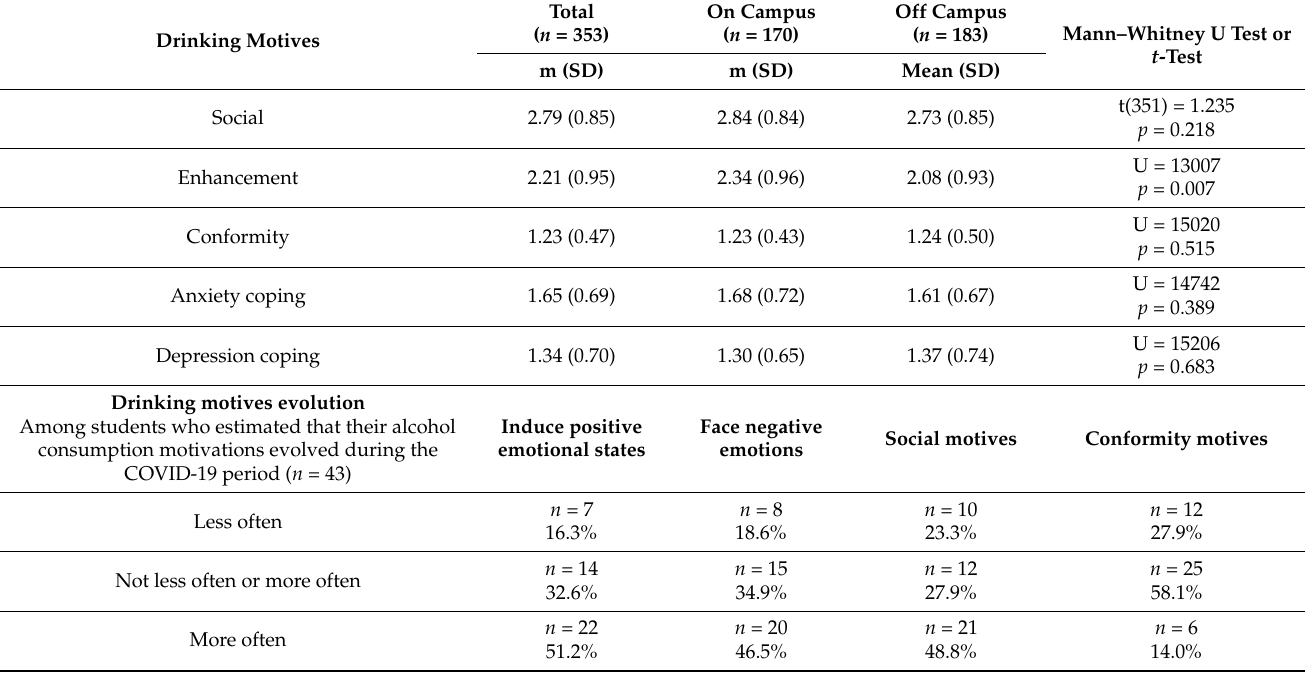
Table 5. Drinking motives depending on residential status during the COVID 19 period ( n =